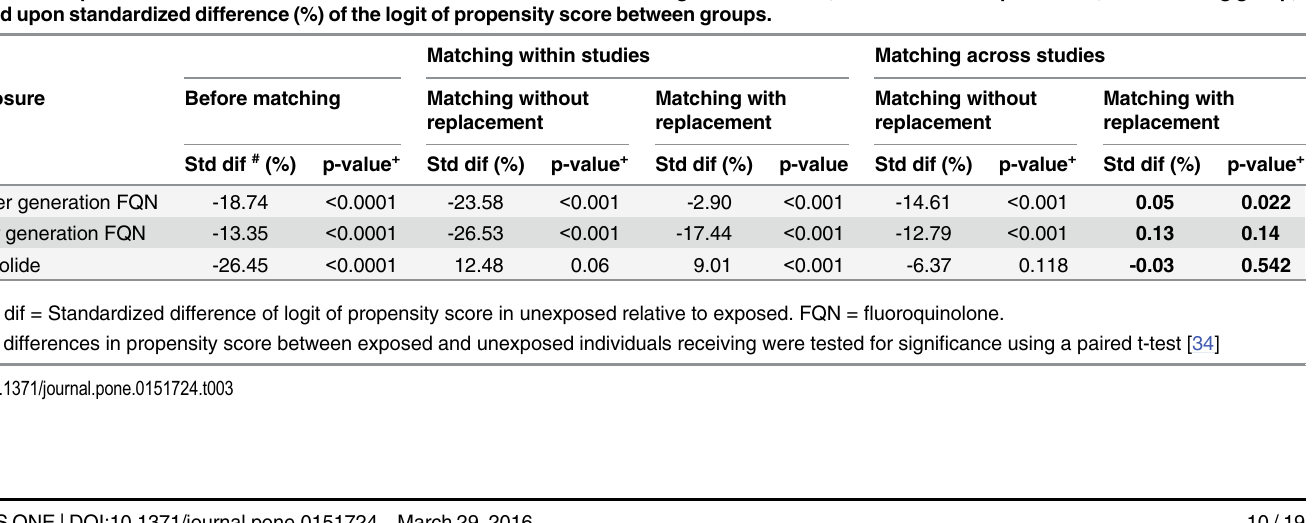
Matching within studies Matching across studies Matching with Matching without Matching with replacement replacement replacement